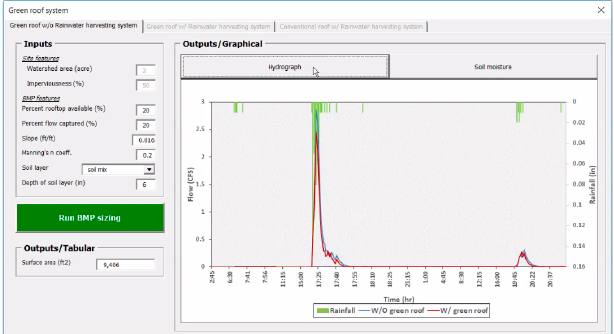
Figure A16. Output hydrograph for green roof system